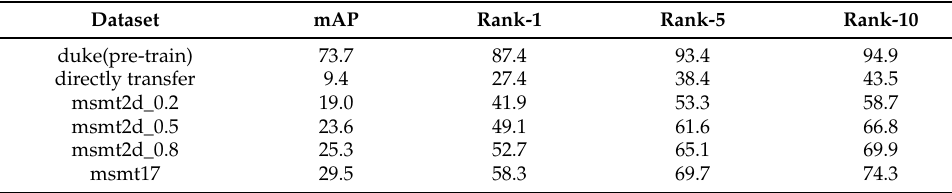
Table 3. The results of ablation experiments for DukeMTMC-reID to MSMT17 dataset.